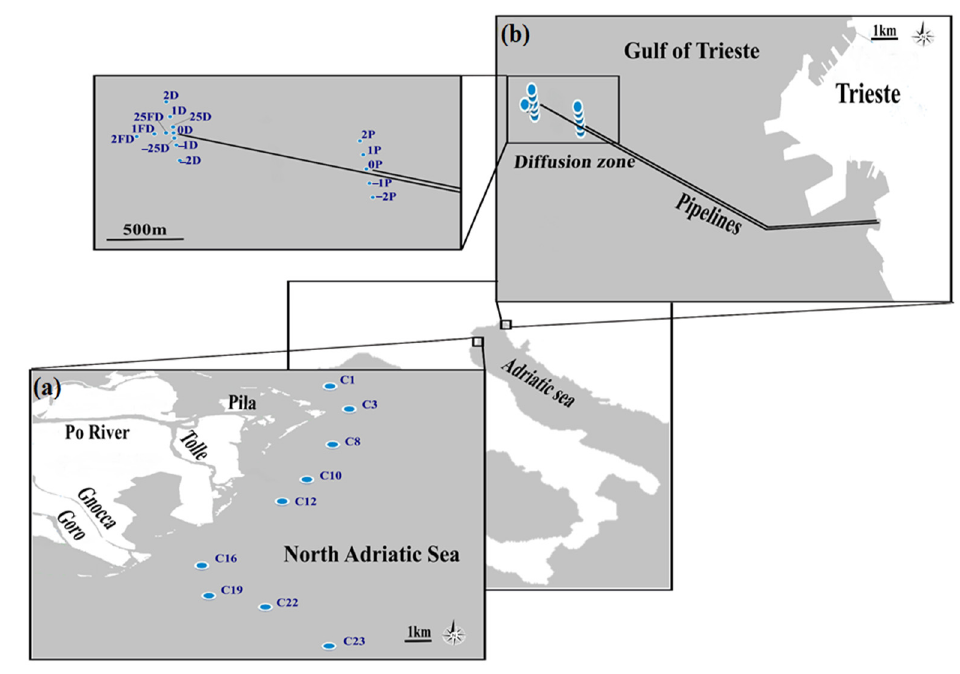
Figure 1. Map showing the location of both study areas: ( a ) the Po River prodelta and ( b ) the area nearby the two outfalls of Servola sewage plant (Gulf of Trieste).